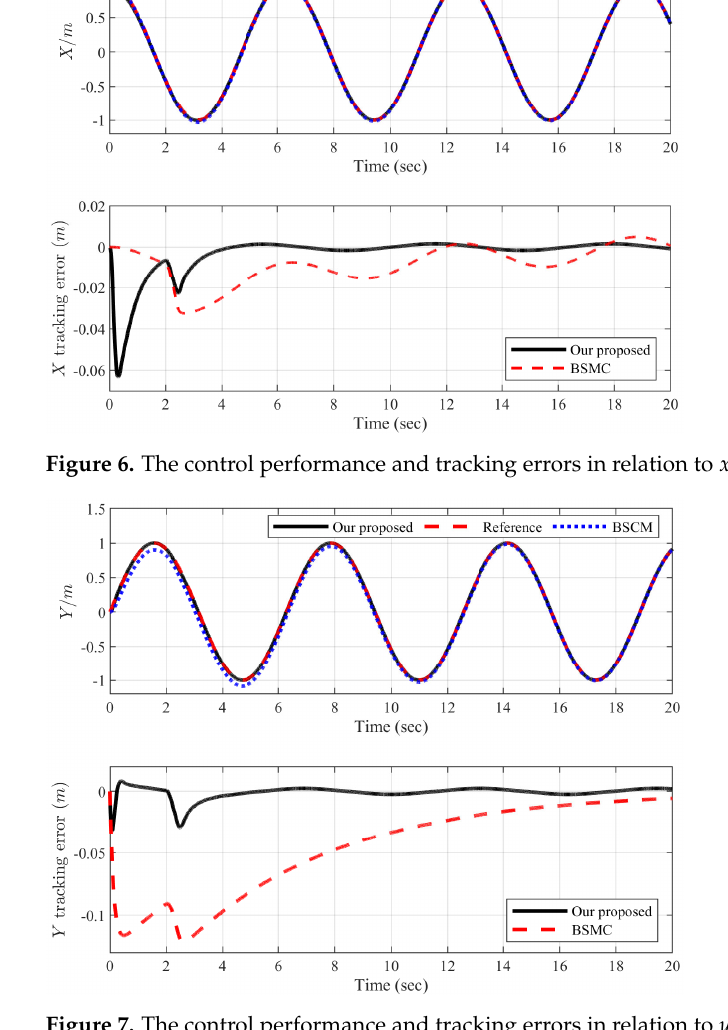
Figure 7. The control performance and tracking errors in relation to y